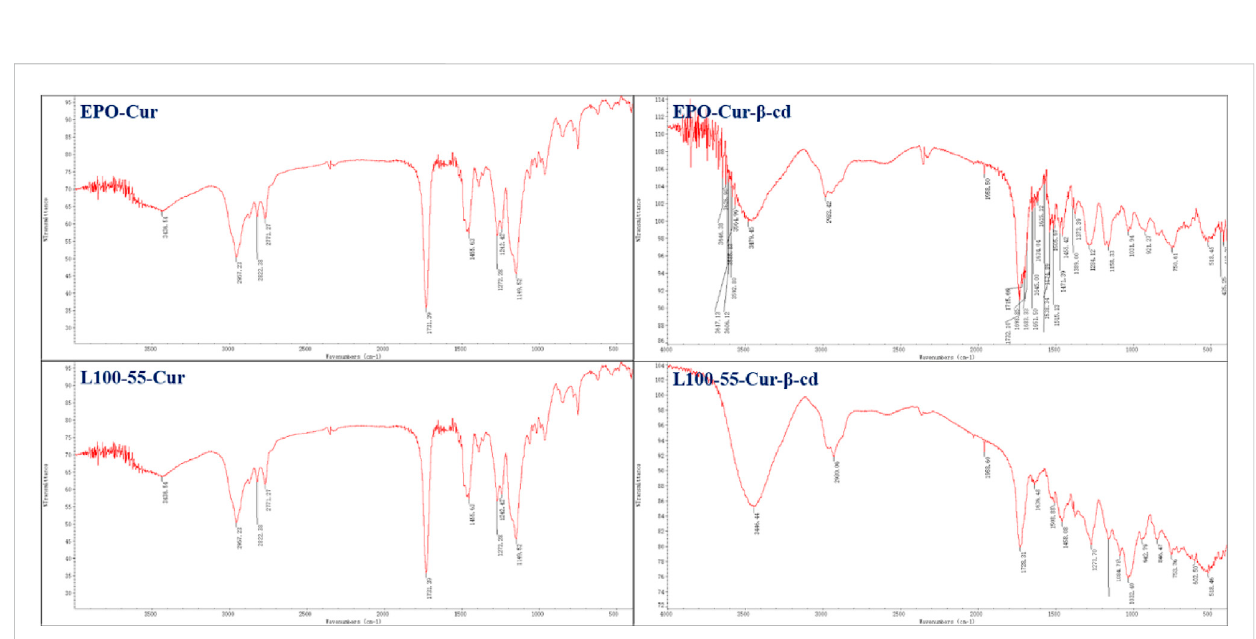
FIGURE 2 FT-IRabsorptionspectrumandcyclodextrinembeddingcharacteristicpeaksoffourcurcumin fl uorescentcomplexes(Itsscanningtimesare16and resolution is 4.0 cm − 1